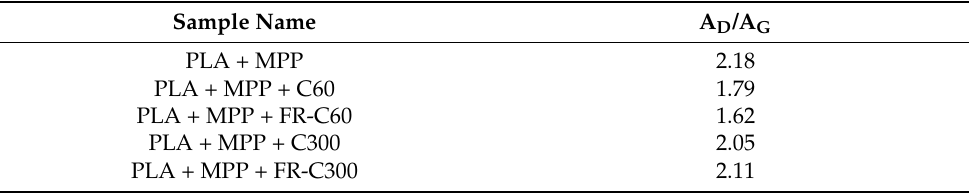
Table 10. Area ratios of the fitted D and G bands of the char